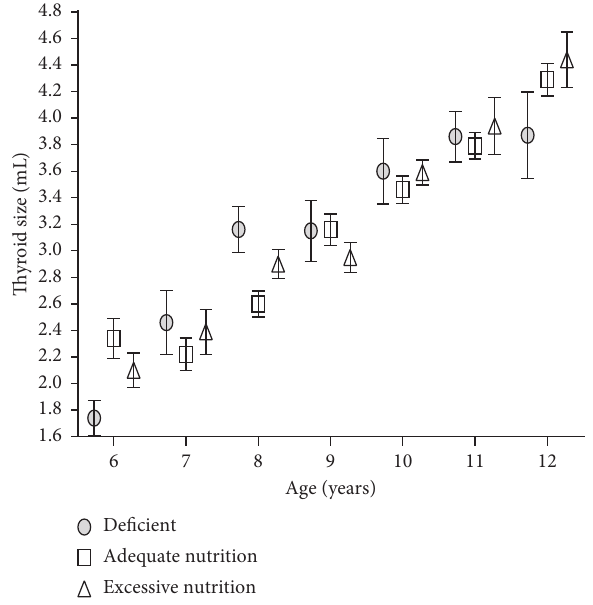
Figure 6: Thyroid volumes in school-aged children with different iodine status. Data are expressed as mean and SEM with whiskers. There was no significant difference in thyroid volumes with respect to iodine status across the various ages ( P > 0 .